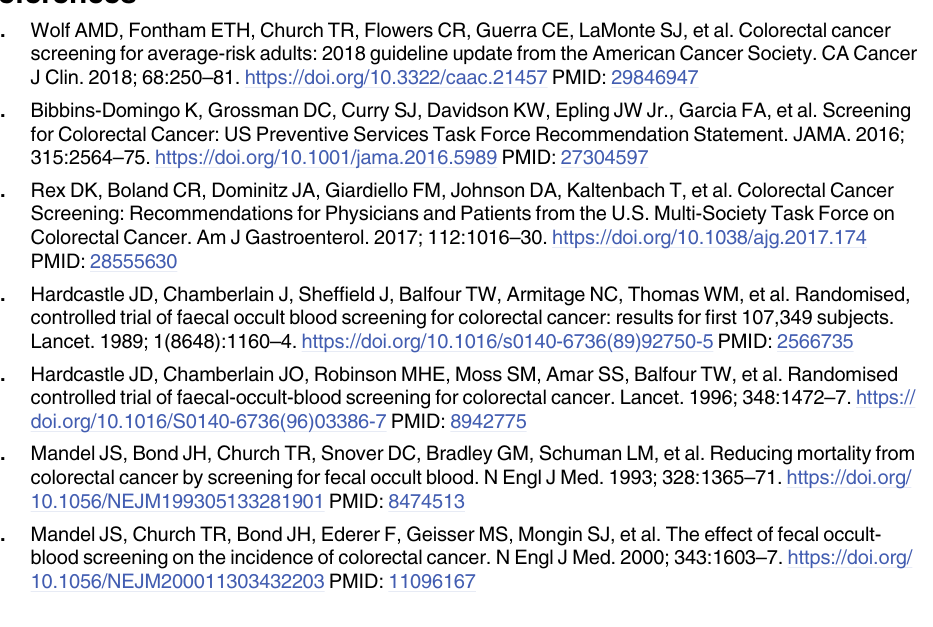
S3 Table. Characteristics of colorectal cancers diagnosed during 2004–2013 in secondary analyses, SEER-Medicare � . S4 Table. Association of screening colonoscopy or flexible sigmoidoscopy with colorectal cancer incidence in secondary analyses, SEER-Medicare � . S5 Table. Endoscopist characteristics in relation to the magnitude of the association of CRC incidence and screening endoscopy history, SEER-Medicare �